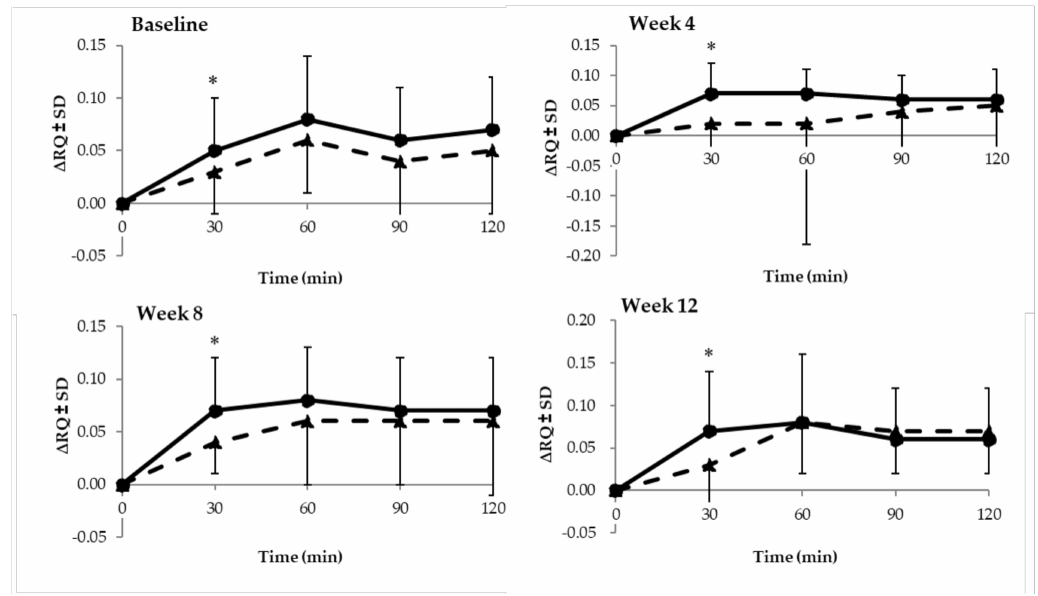
Figure 3. Change in respiratory quotient (RQ) ( ∆ RQ) from fasting state to 30, 60, 90, and 120 minutes after consumption of the test breakfast with isomaltulose (triangles, dotted lines) and sucrose (circles, solid line) at all four study visits. * Independent sample t-test: p < 0.05.